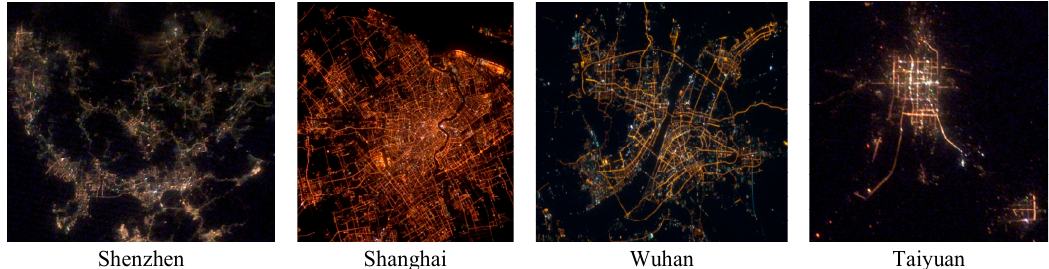
Figure 9. Satellite photography of the four experimental cities.